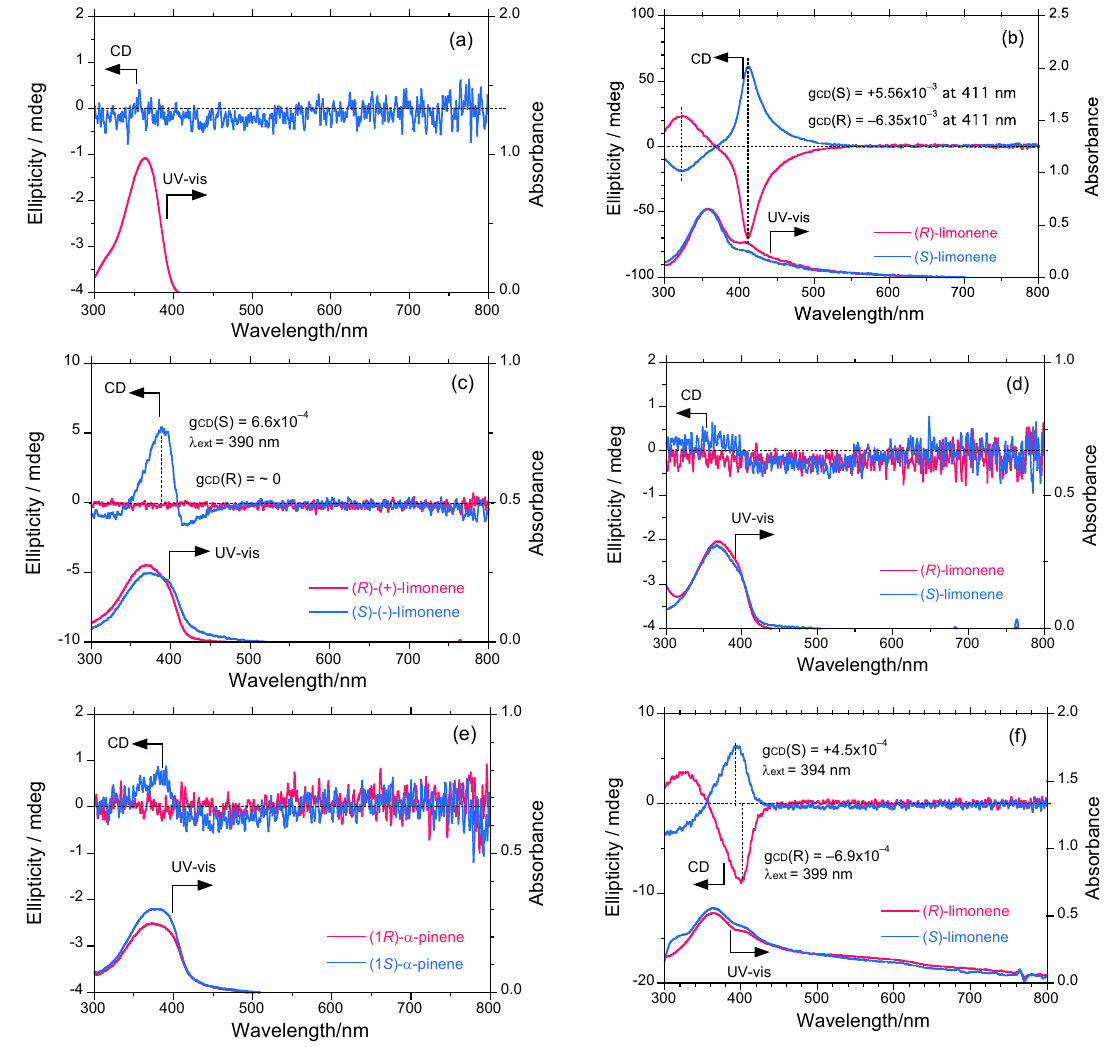
Figure 3. The CD and UV-vis spectra of PF8P2 in ( a ) chloroform/methanol = 0.3/2.7 (v/v), ( b ) chloroform/( R )- and ( S )-limonene/methanol = 0.3/1.1/1.6 (v/v/v), ( c ) chloroform/ ( R )- and ( S )- limonene/ethanol = 0.3/1.1/1.6 (v/v/v), ( d ) chloroform/( R )- and ( S )-limonene/ isopropanol = 0.3/1.1/1.6 (v/v/v), ( e ) chloroform/(1 R )- and (1 S )-  -pinene/methanol = 0.3/1.1/1.6 (v/v/v), ( f ) tetrahydrofuran/( R )- and ( S )-limonene/methanol = 0.3/1.1/1.6 (v/v/v). [ PF8P2 ] = 1.0 × 10 −5 mol L −1 and measurements are employed at 25 °C. Stirring conditions: 0 CW stirring operation at 800